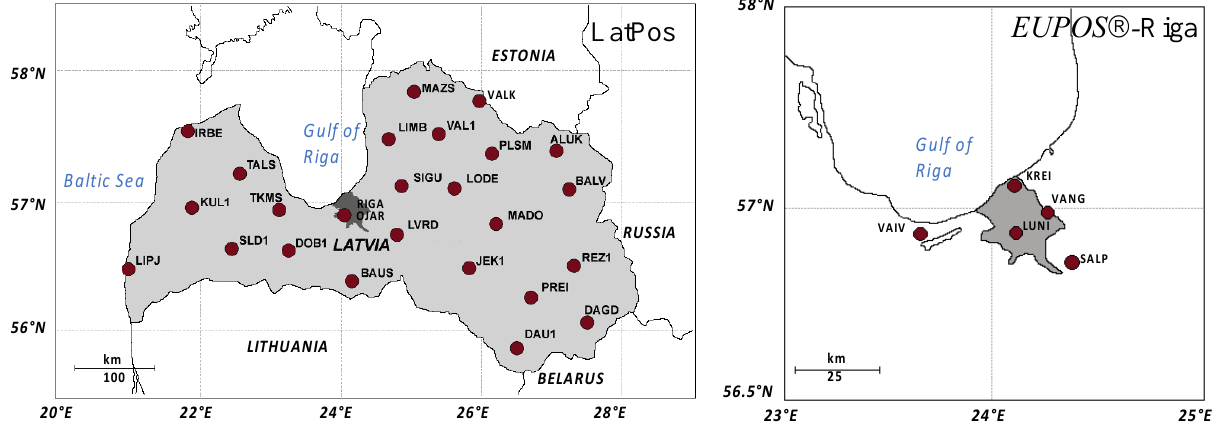
Figure 1. A schematic map of the Latvian CORS networks.